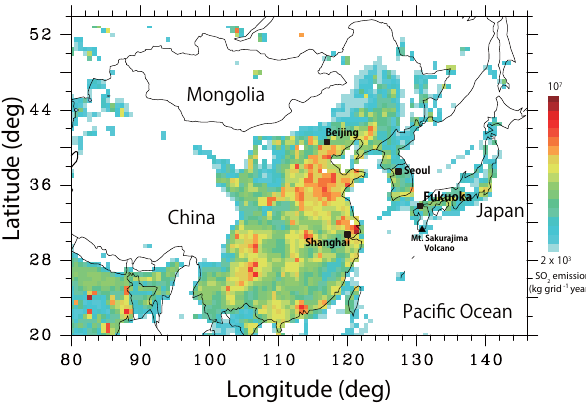
Figure 1. SO 2 emissions intensity (based on 2008 data) and obser- vation sites: Fukuoka and Mt. Sakurajima